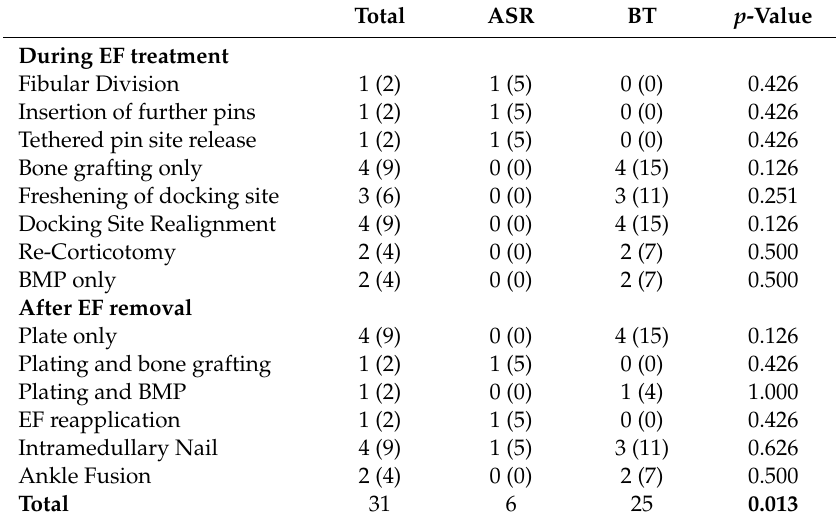
Table 3. Surgeries during and after external fixator (EF) treatment in the acute shortening / relengthening (ASR) group and the bone transport (BT)